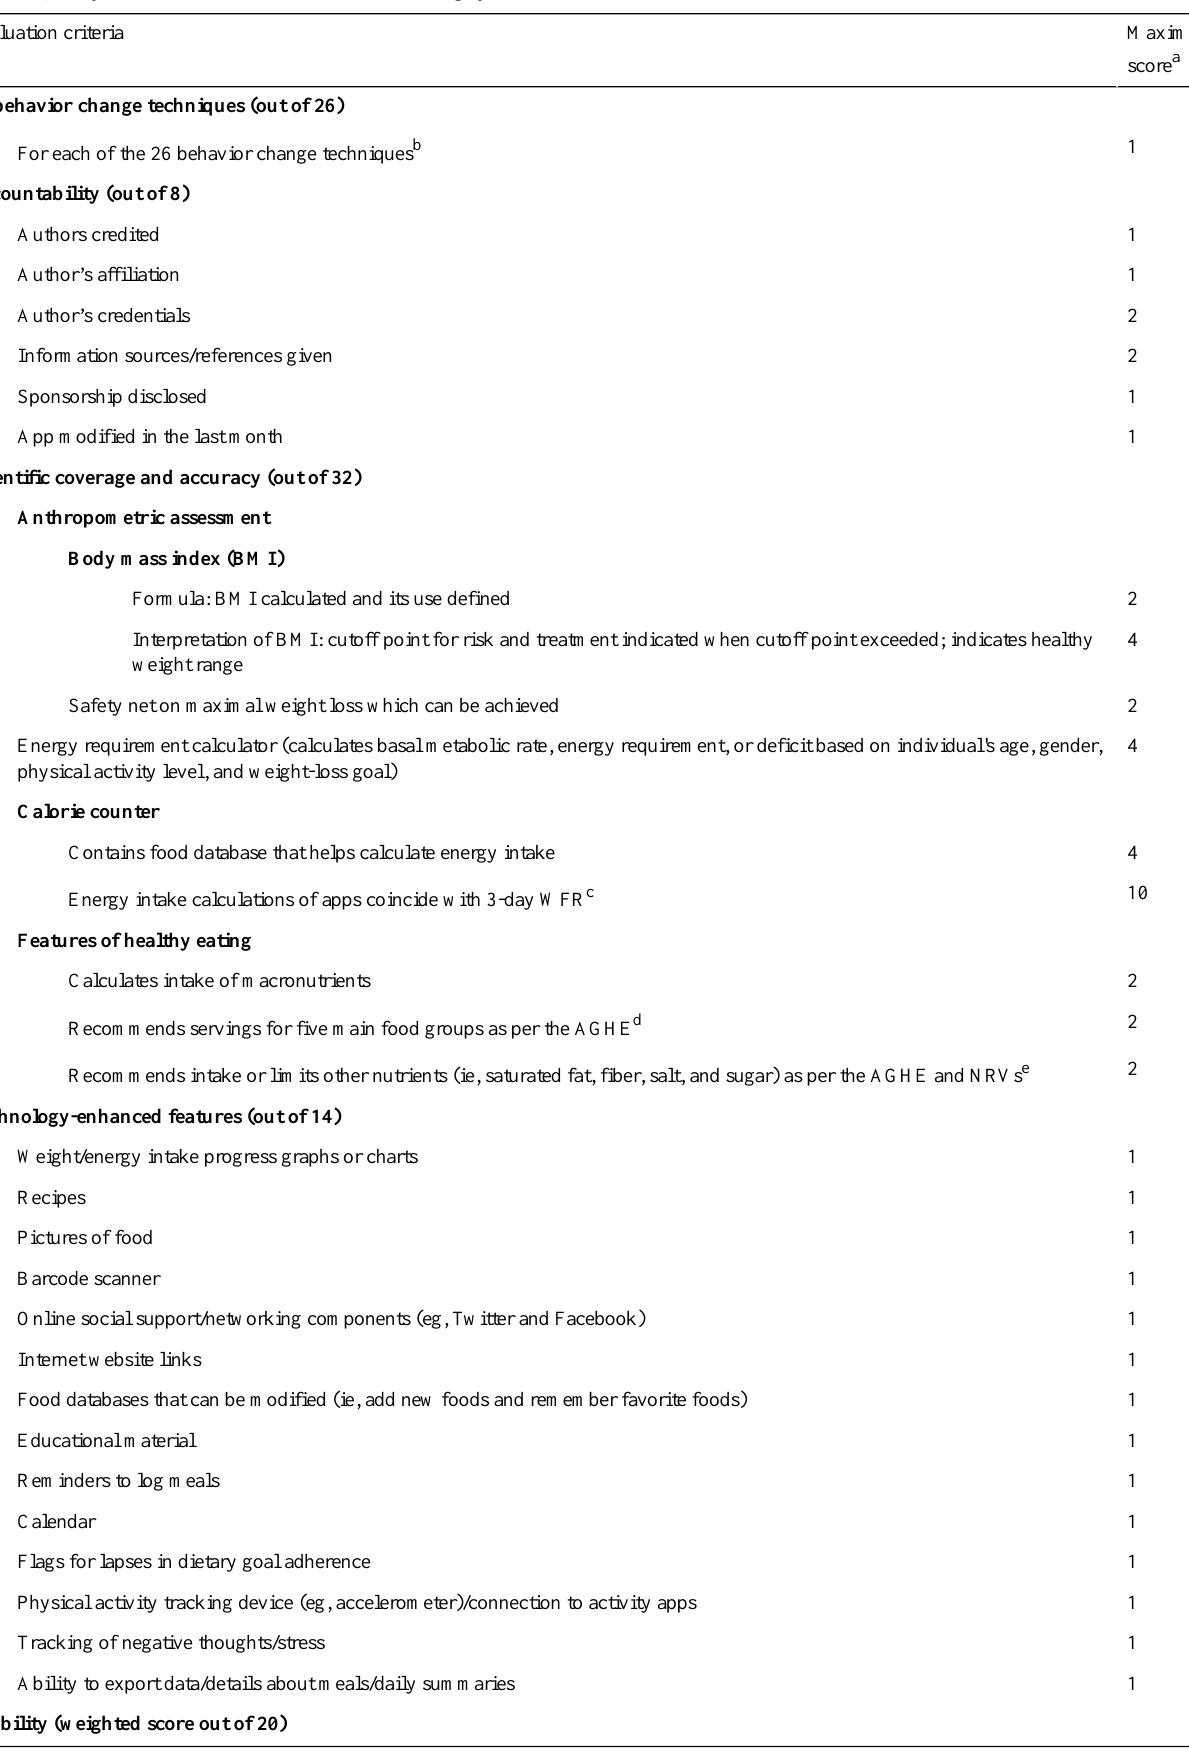
Table 1. Quality assessment evaluation criteria and scoring